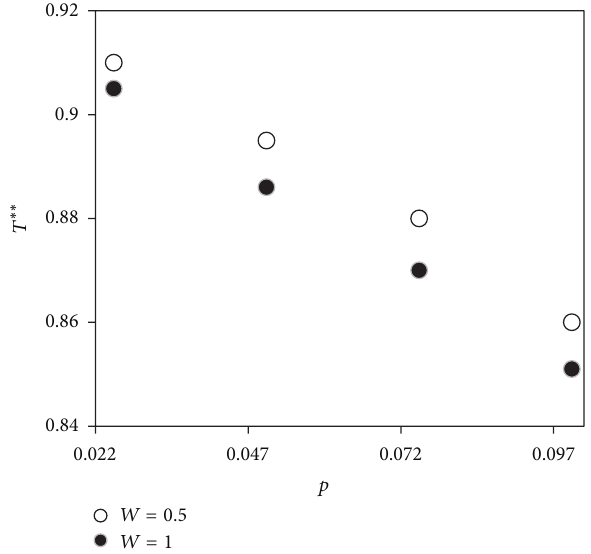
Figure 5: 𝑇 ∗∗ is plotted as a function of 𝑝 for different values of 𝑊 .